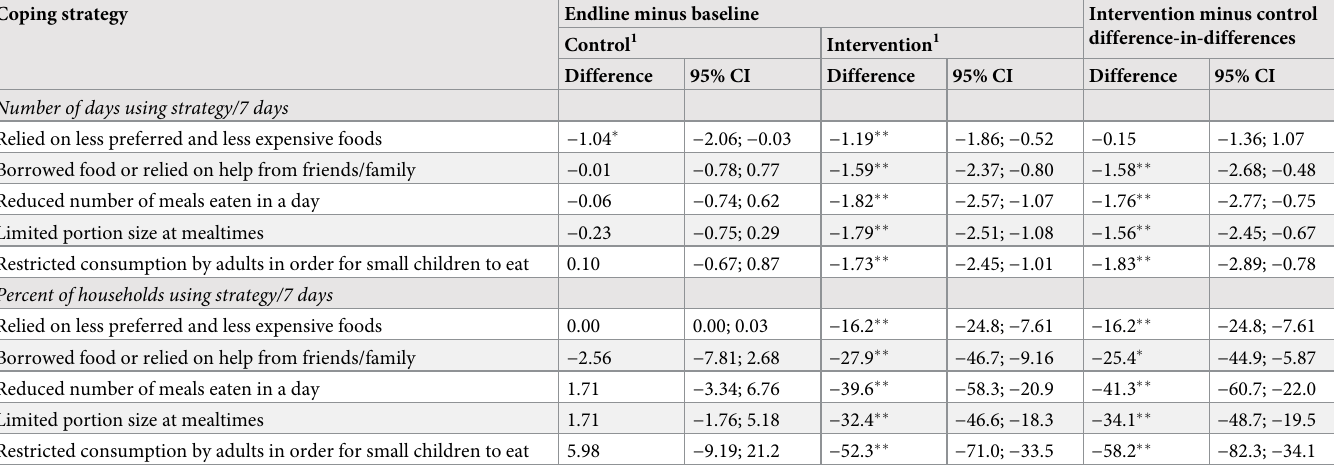
Table 4. Difference between endline and baseline for each study arm and the difference-in-differences for coping